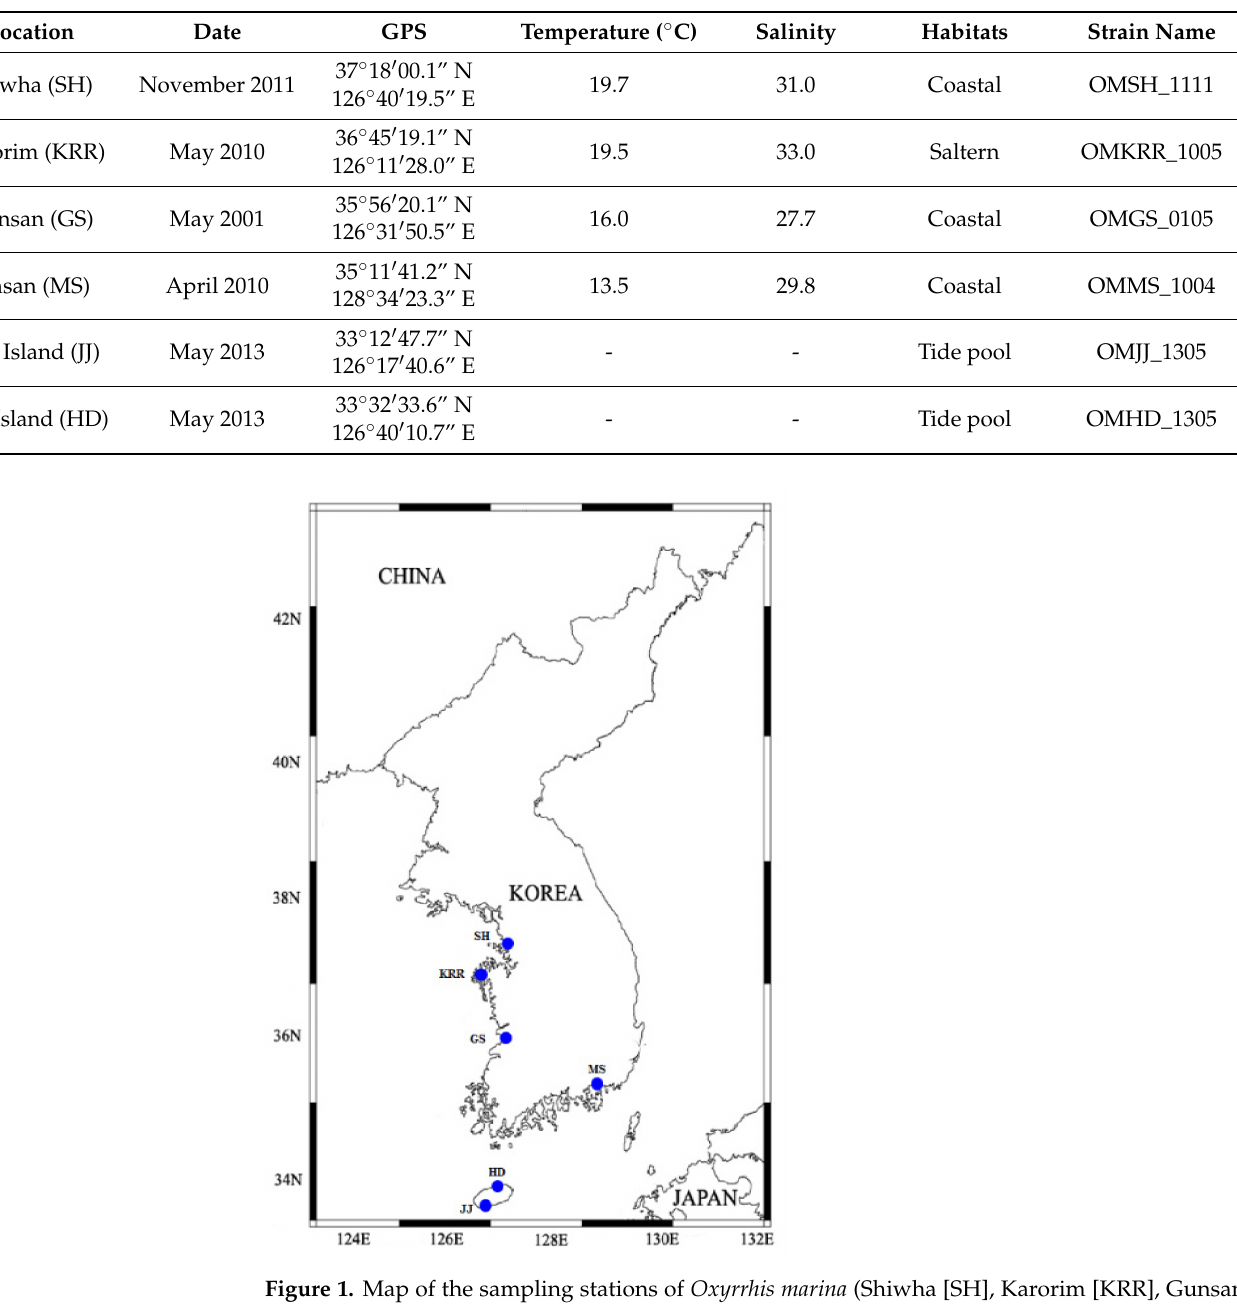
Table 2. Environmental conditions of collected Oxyrrhis spp. in the coastal waters of Korea.